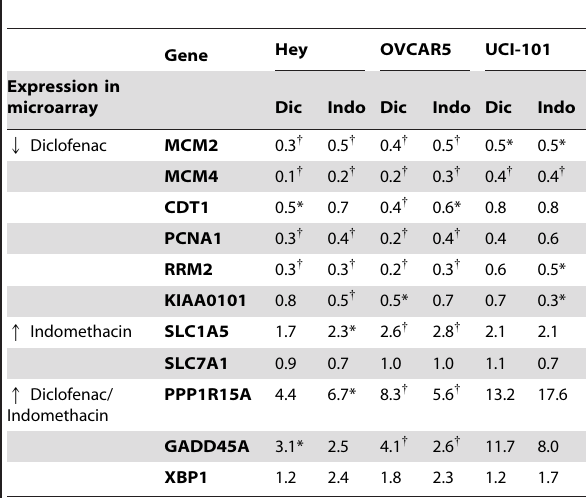
Table 1. Expression levels of target genes by Real-Time RT-